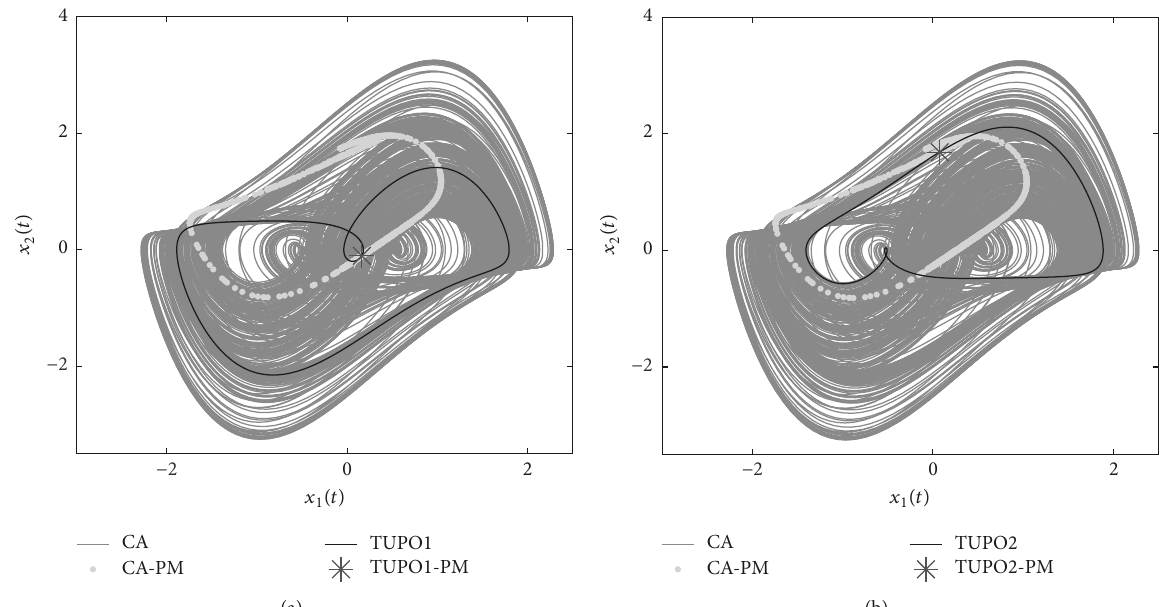
Figure 7: Target UPOs (TUPO1 and TUPO2) embedded in the chaotic attractor (CA) of the forced vdP oscillator. The points for the target UPOs and the chaotic attractor in the Poincar´e map (PM) are represented by asterisk and gray bullet, respectively.